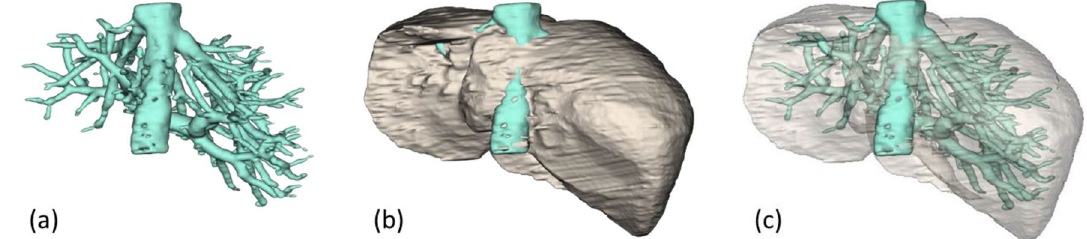
Figure 14. Simultaneous extraction of a liver ( b ) and its vasculature, including IVC ( a ), with their fusion ( c ).